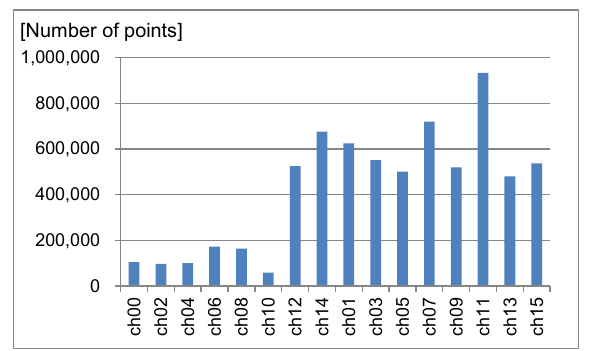
Figure 10. Counted number of acquired points by laser channel with even- and odd-numbered channels appearing the left and right of the plot,